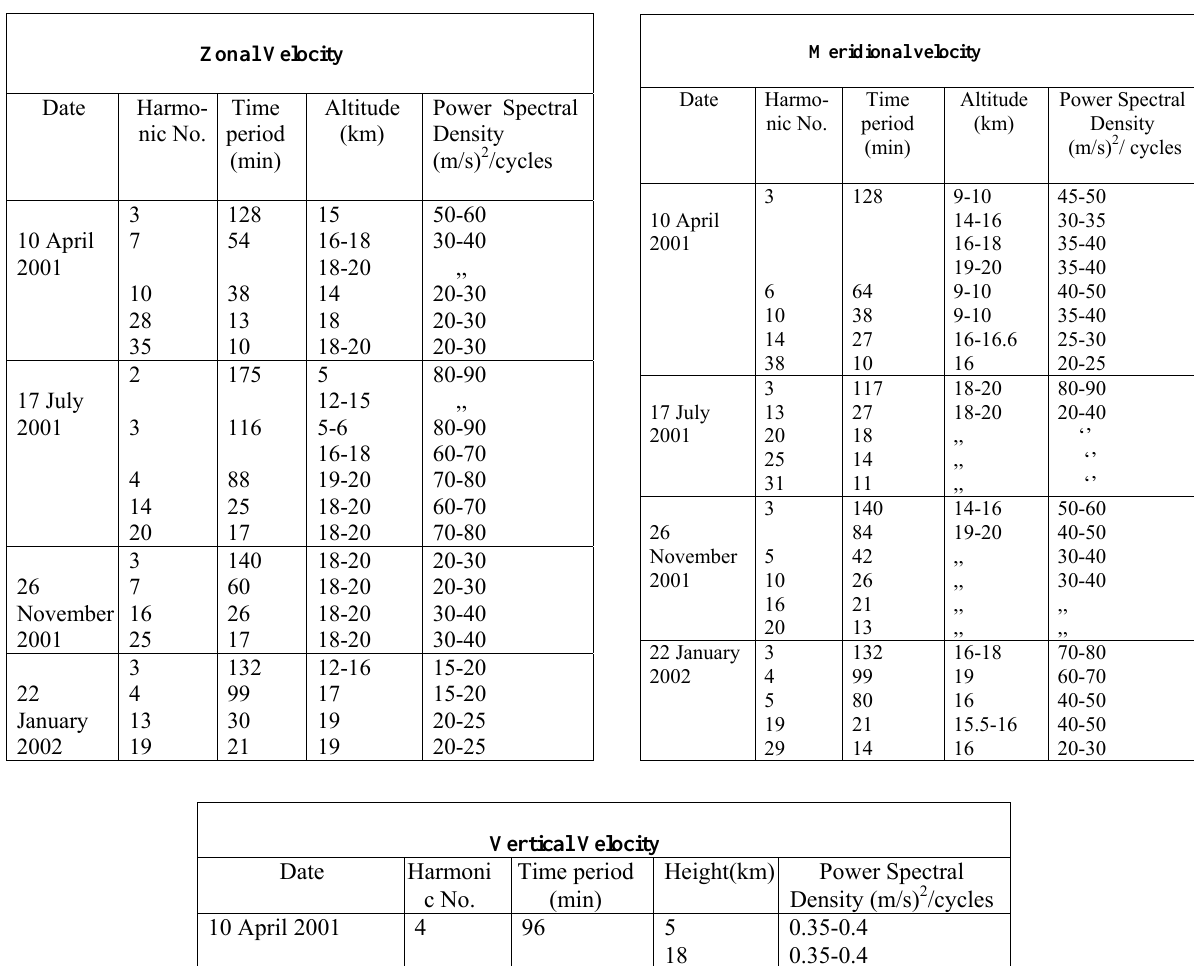
Table 1. Power Spectral Densities for zonal, meridional and vertical velocity fluctuations for different days. Table